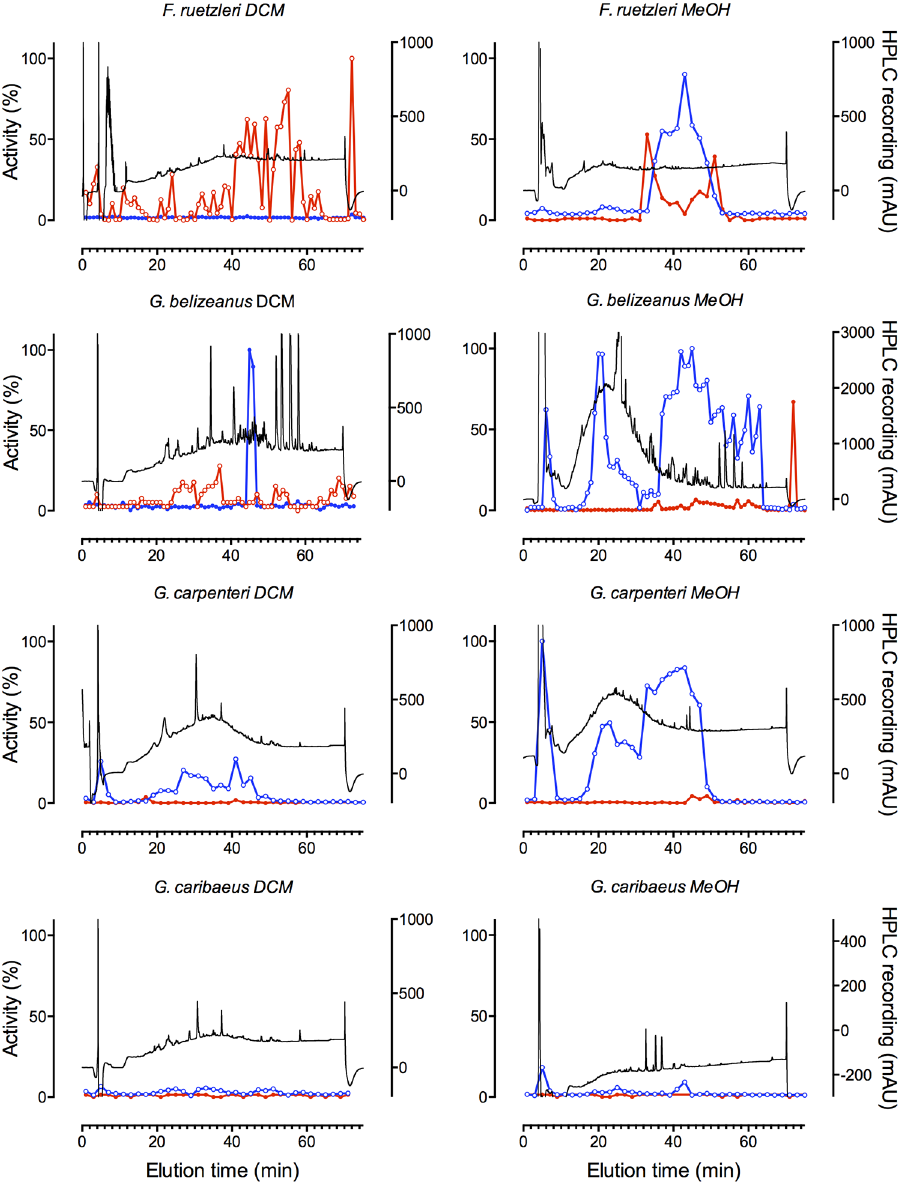
Fig 4. CTX-like and MTX-like activity in HPLC fractionated Gambierdiscus and Fukuyoa extracts. Dichloromethane (DCM) and methanol (MeOH) extracts of Caribbean F . ruetzleri (Belize, Gam1), G . belizeanus (St. Barthelemy Island, CCMP 399), G . carpenteri (Belize, GT4) and G . caribaeus (Belize, Gam 19) isolates fractionated by HPLC with UV detection (black trace). Fractions were tested for activity using the FLIPR TETRA assay. CTX-like (red trace) and MTX-like (blue trace) activity was expressed as percent activity (%) relative to the most active MTX and CTX-containing fraction tested in this study.